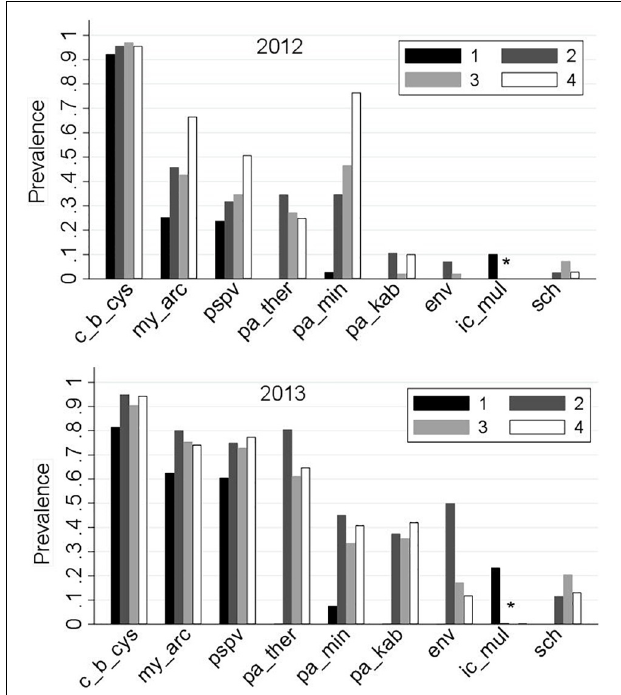
FIGURE 4 | Distribution of the prevalences of the nine common infectious agents (as described in Table 1 ) for 2,006 Fraser River juvenile Sockeye salmon by sampling region and year. Sampling regions: (1) Freshwater, (2) Strait of Georgia, (3) Discovery Islands, and (4) Johnston Strait and north. ∗ ‘ic-mul’ is a freshwater